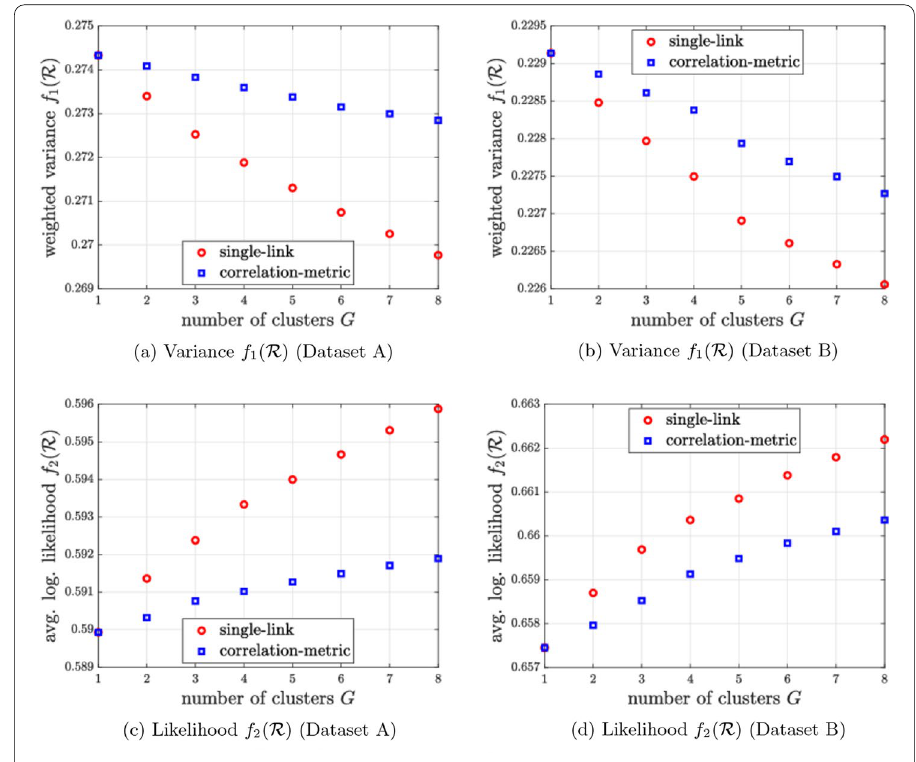
Fig. 2 Results of performance